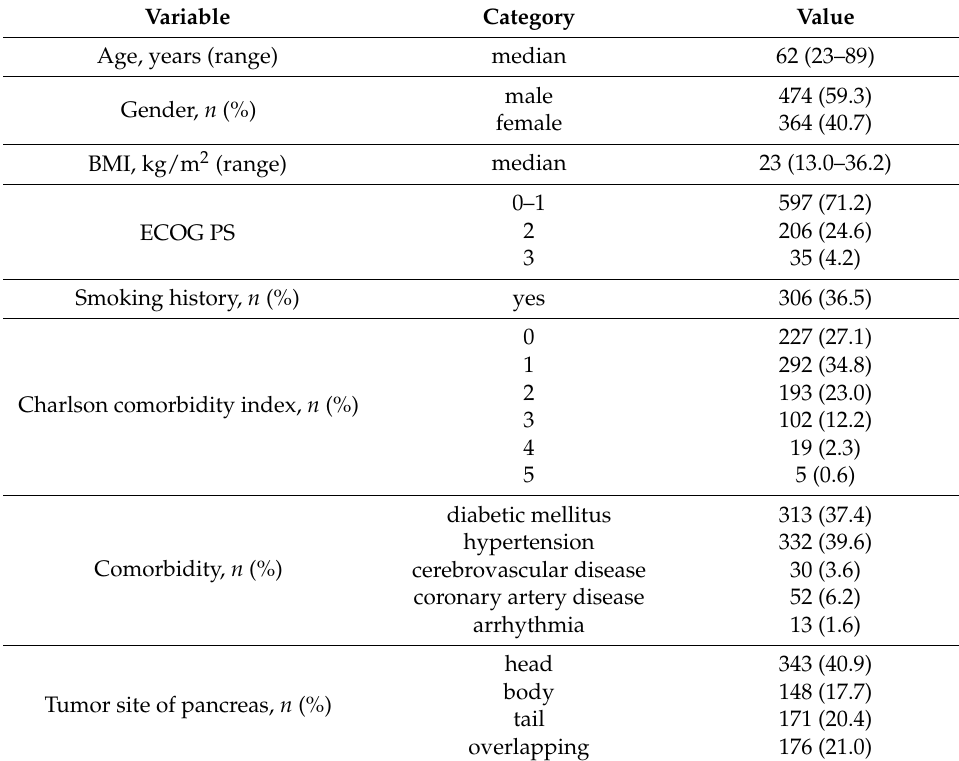
Table 1. Basic patient characteristics ( n =